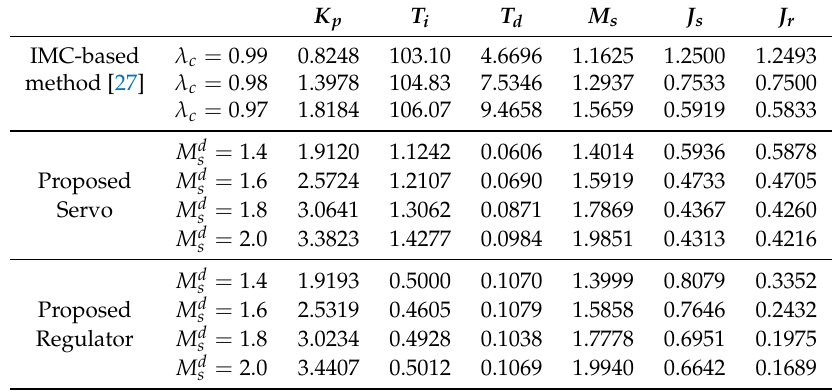
Table 5. Proportional-integral-derivative parameters, M s , and sum of absolute errors (SAE) values using the proposed and internal model control (IMC)-based methods for Equation